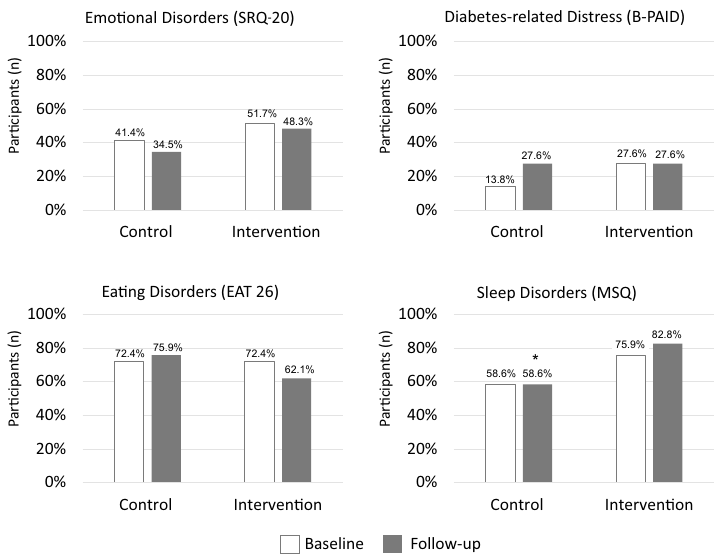
Figure 2. Participants with positive screening for proposed assessments, based on cutoff values and comparison between intervention and control groups. Legend: Number of participants who present positive screening based on pre-established cutoff values. For the evaluation of emotional disorders, a score greater than or equal to 7 on SRQ-20 is considered positive. Diabetes-related emotional distress is considered when the B-PAID score is greater than or equal to 40. The presence of positive screening for eating disorders is considered when the EAT 26 score is greater than or equal to 20. A positive screening for sleep disorders is considered when a score greater than or equal to 31 is present in the MSQ. *P = 0.04 for comparison between groups after the